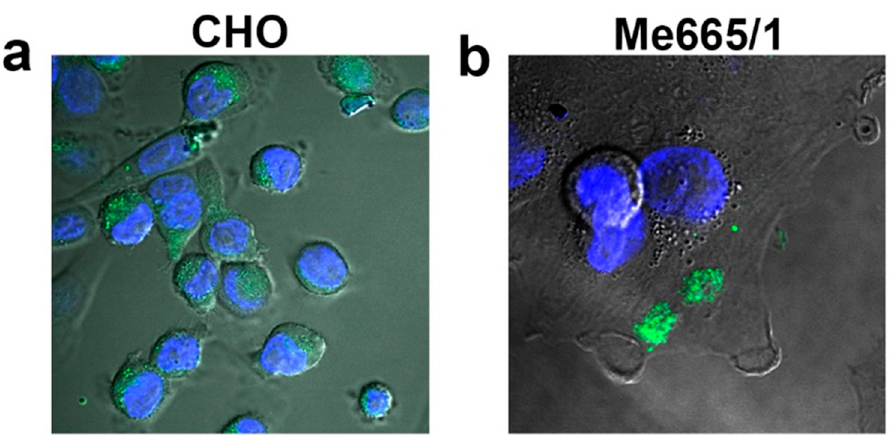
Figure 5 . Fluorescent sEVs uptake by different cell lines. Confocal fluorescence microscopy images of green fluorescent sEVs derived from melanoma Me665/1 cells transferred on ( a ) CHO cells and ( b ) Me665/1 cells in nonspecific conditions [66]. Blue-fluorescent nuclei are stained with DAPI.